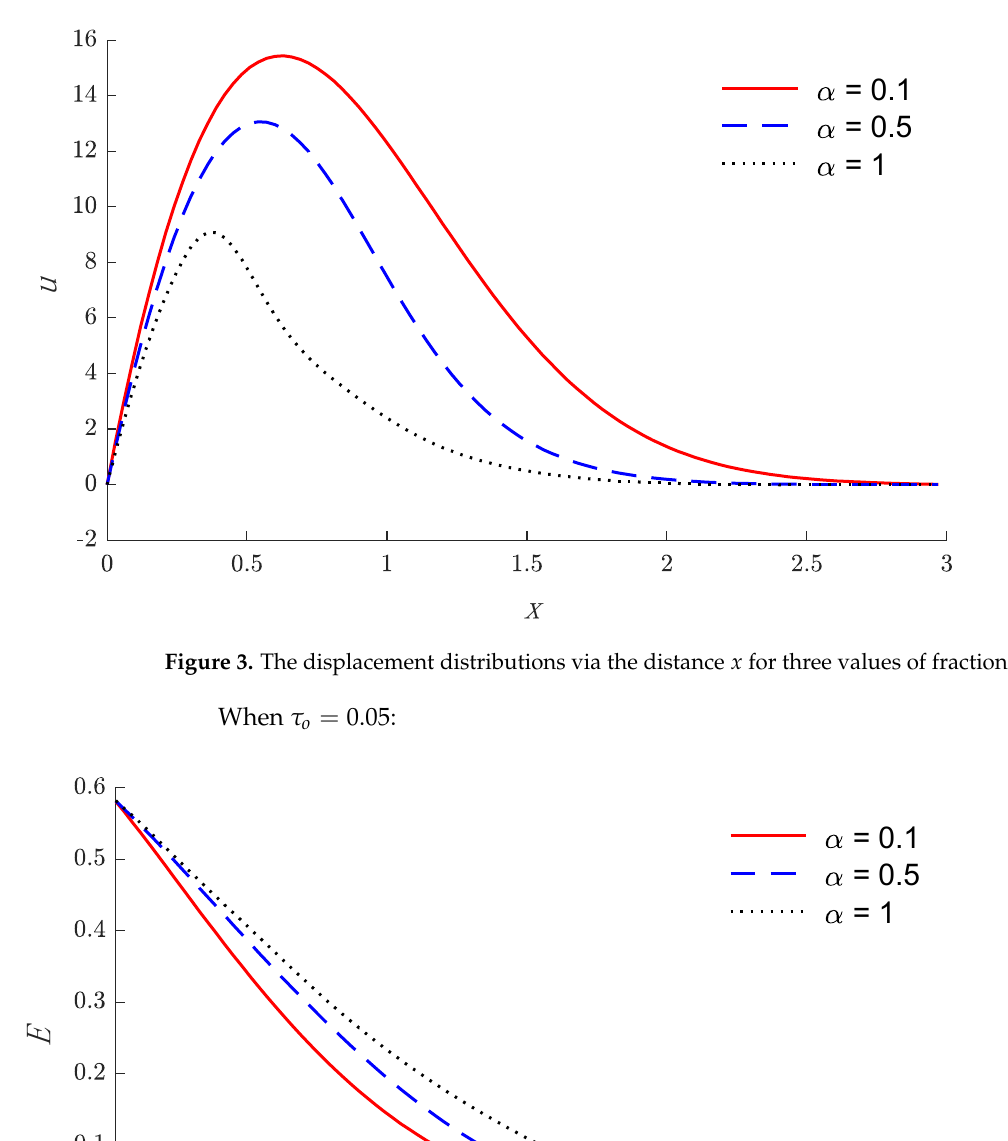
Figure 2. The electric potential distribution via the distance 𝑥 for three values of fractional param- eters. When 𝜏 (cid:3042) = 0.05 :